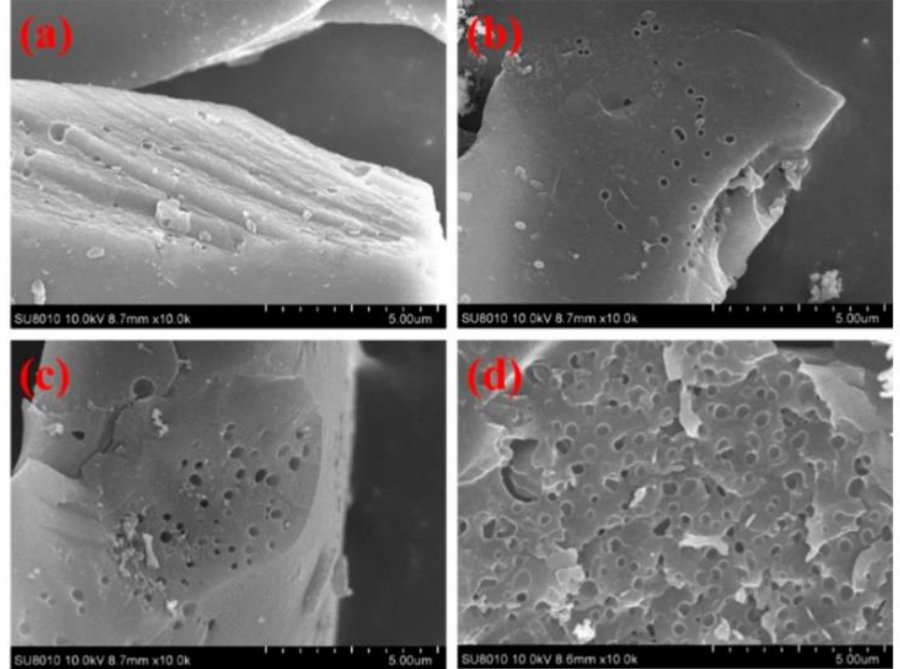
Figure 38. SEM images of ( a ) NPC-500, ( b ) NPC-600, ( c ) NPC-700, and ( d ) NPC-800 (reproduced from the work in [83] with permission). The HPC-800 sample activated at 800 ◦ C achieved the highest specific capacitance of 402 F/g at 0.1 A/g and 249 F/g at 10 A/g, and more than a 99.0% capacitance retention ratio after 500 charge/discharge cycles in a three-electrode system